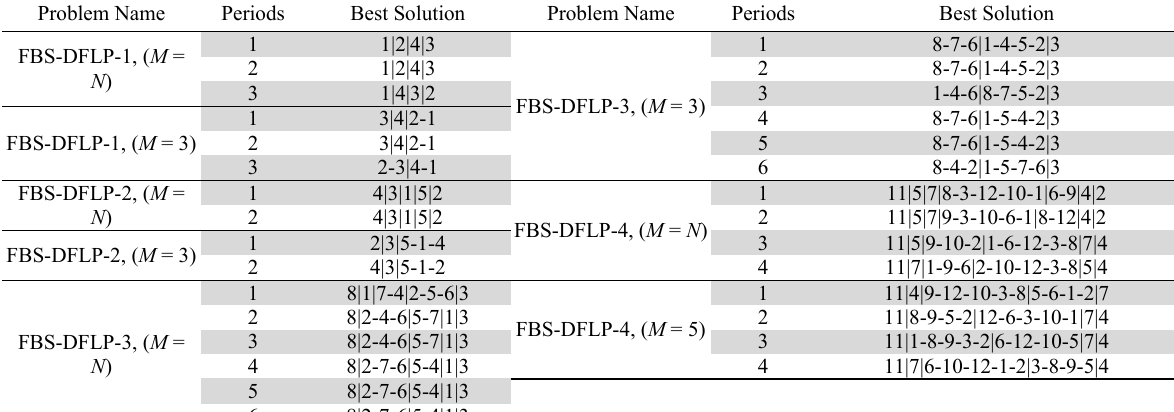
Best solution found by the proposed SA heuristic for the Mazinani et al. (2013) FBS based test